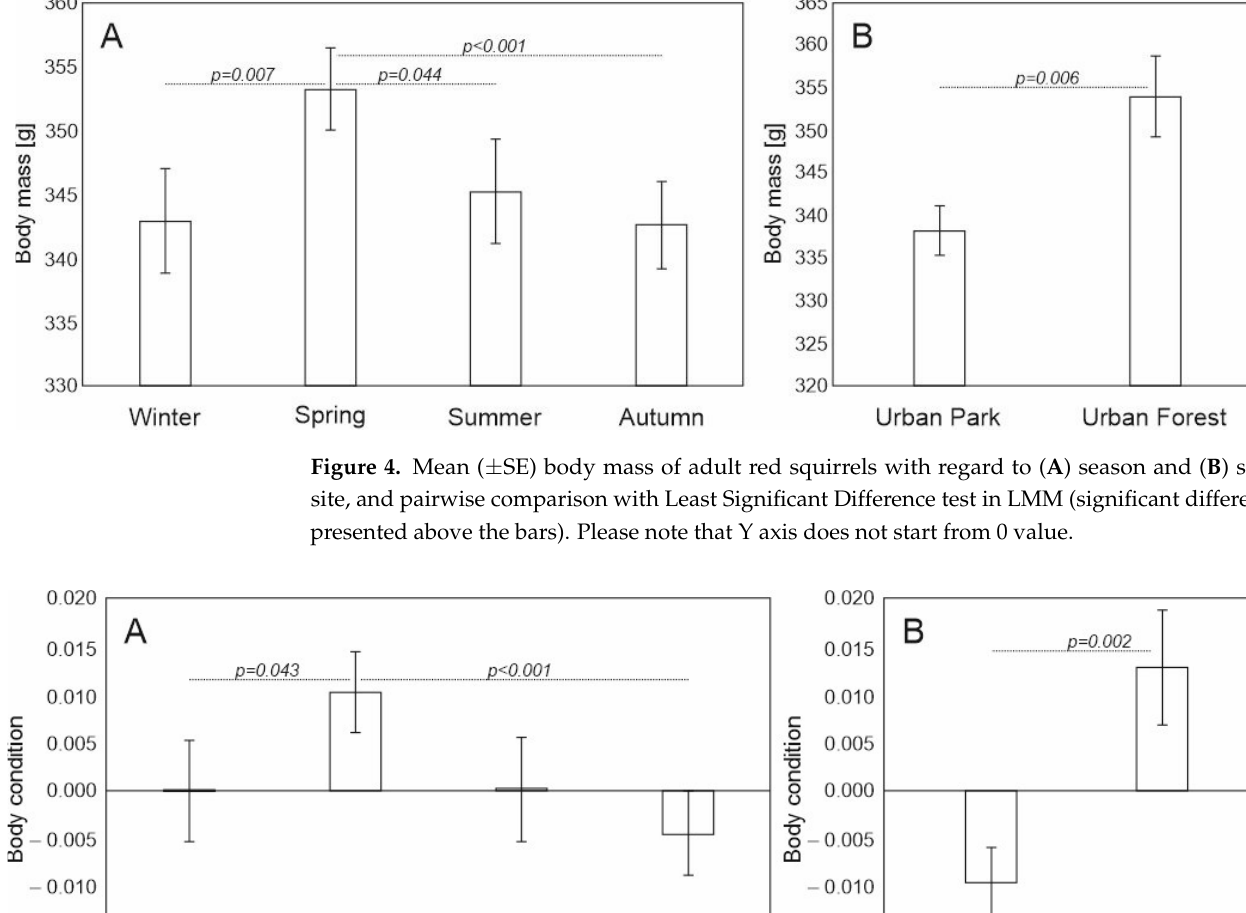
Figure 5. Mean (±SE) body condition of adult red squirrels with regard to ( A ) season and ( B ) study site and pairwise comparison with Least Significant Difference test in LMM (significant differences presented above the bars).